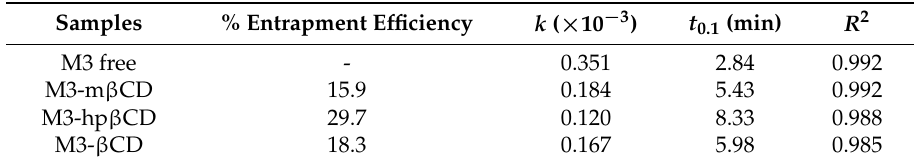
Table 2. Kinetic parameters of M3-CD complexes.